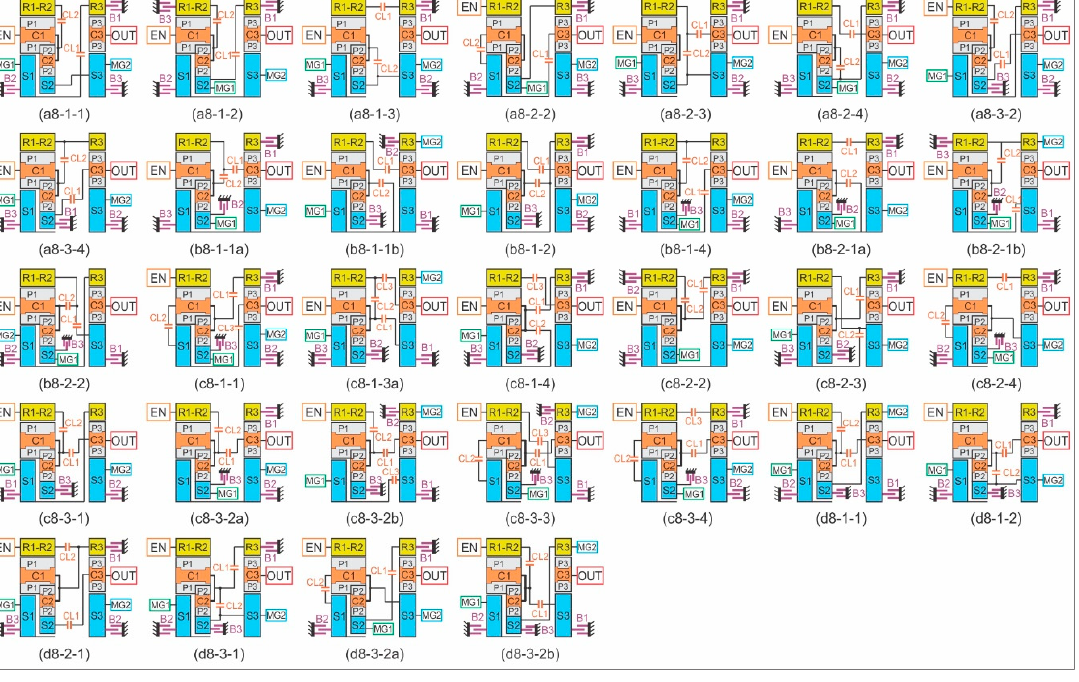
Figure 15. Atlas of new hybrid transmissions.